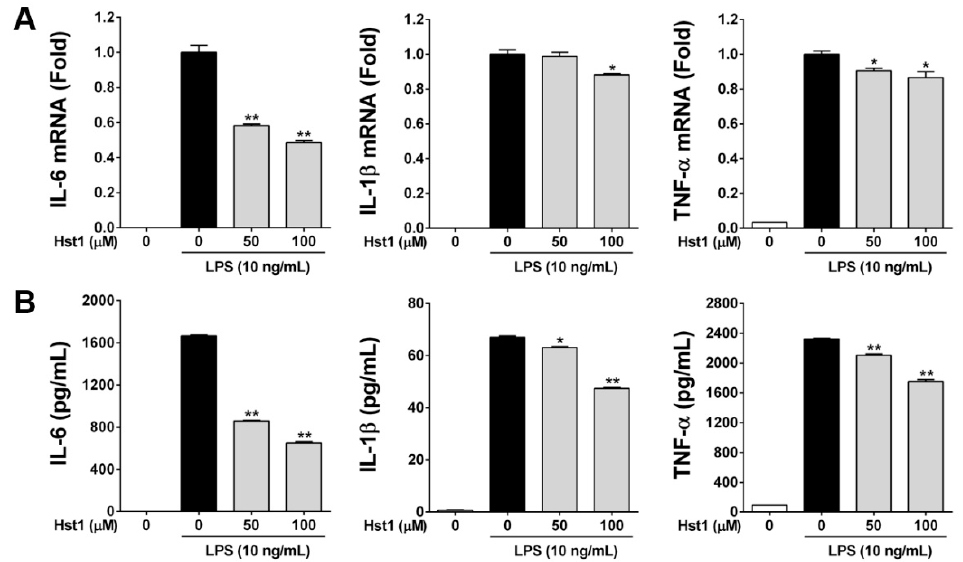
Figure 2. Effects of Hst1 on production of pro-inflammatory cytokines in LPS-stimulated RAW264.7 cells. ( A ) The mRNA levels of IL-6, IL-1 β , and TNF- α were determined by using qRT-PCR. RAW264.7 cells were pre-treated with Hst1 at the indicated concentrations (50 and 100 µM) for 2 h and then exposed to Hst1 with LPS (10 ng/mL) or LPS alone for 16 h. The expression level of GAPDH mRNA served as the internal control for the normalization of IL-6, IL-1 β , and TNF- α mRNAs expression. These results are displayed in fold of LPS alone samples. Gene expression analysis revealed a statistically significant reduction in inflammatory cytokine gene expression by treatment with Hst1. Each value represents the mean